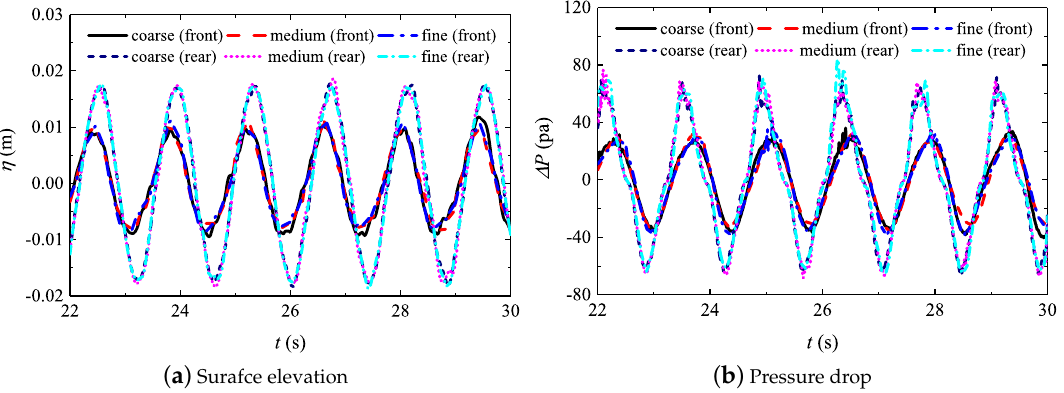
Figure 9. Convergence tests of surface elevation and pressure drop in the front and rear chambers for grids with different